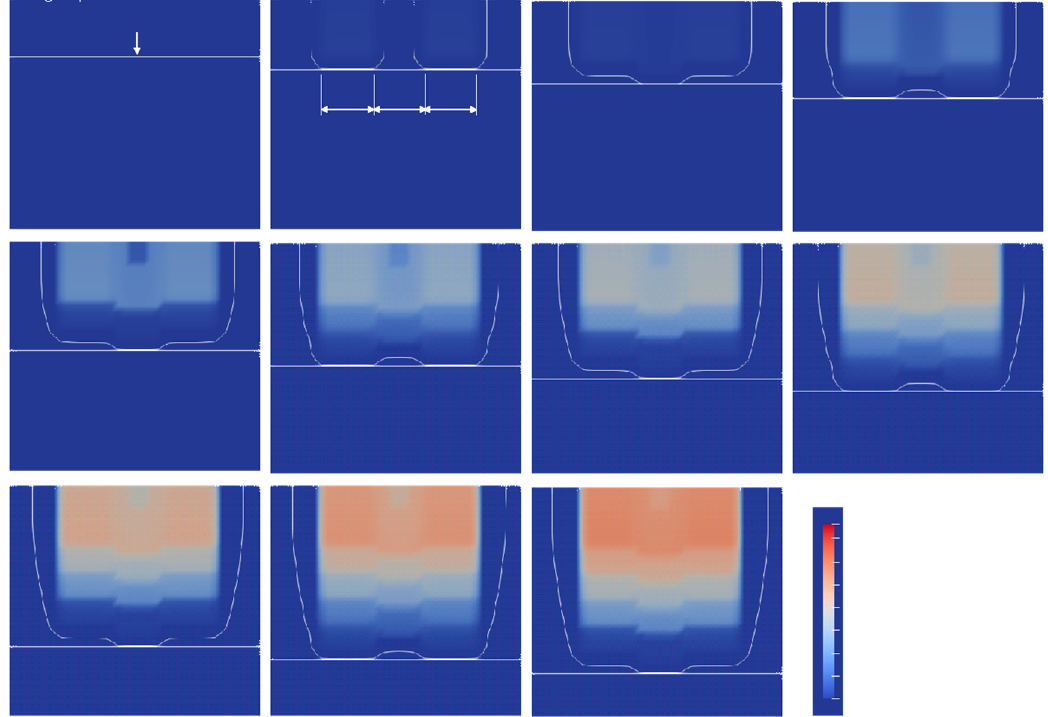
Figure 7. Contour plot of normalized oxygen concentration of 0.9 and C = C bond conversion distribution at a lift-up speed of 0.1 mm/s and alternating UV light position.